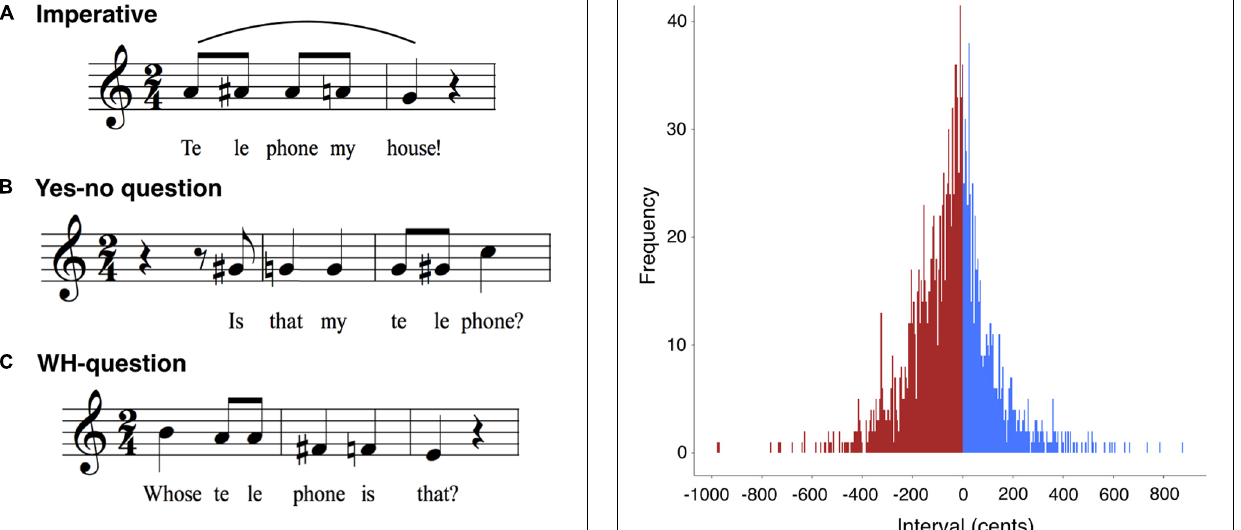
Figure 8 looks at the occurrence of interval categories across all productions of the 19 test-items by the 19 participants. A total of 1700 intervals was measured after discarding items having creaky voice on the terminal syllable. Among the intervals, 37% were ascending intervals (0 cents is included in this group), while 63% were descending intervals. The mean interval size was − 45